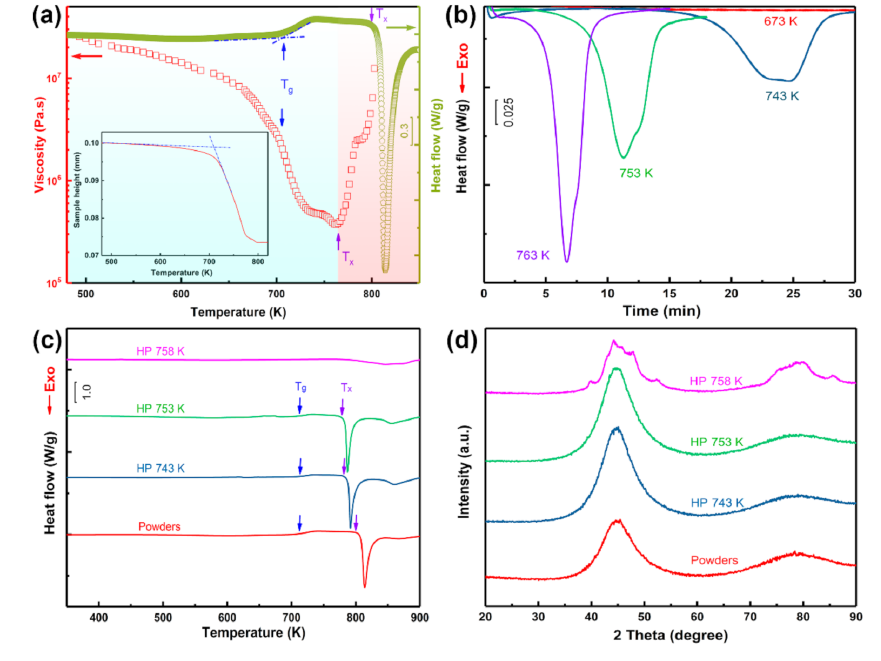
Figure 4. ( a ) Isochronal differential scanning calorimetry (DSC) scan (40 K/min) and viscosity vs. temperature (40 K/min) for the Zr 48 Cu 36 Al 8 Ag 8 glassy powder; inset: change of the sample height as a function of temperature; ( b ) isothermal DSC scans of the powder carried out at 673, 743, 753, and 763 K; ( c ) isochronal DSC scans (40 K/min) for the Zr 48 Cu 36 Al 8 Ag 8 glassy powder and bulk specimens hot pressed (HP) at different temperatures; ( d ) XRD patterns of as-atomized powder and hot-pressed